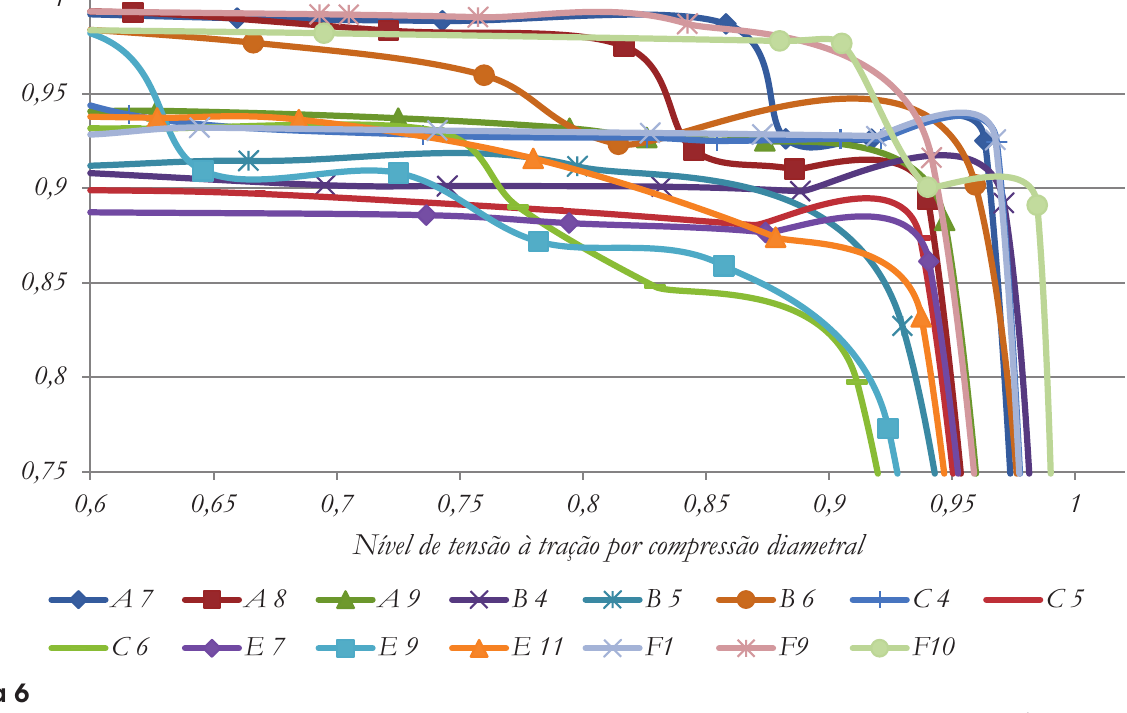
Resumo do comportamento da onda longitudinal em amostras de concreto submetidas à tração por compressão